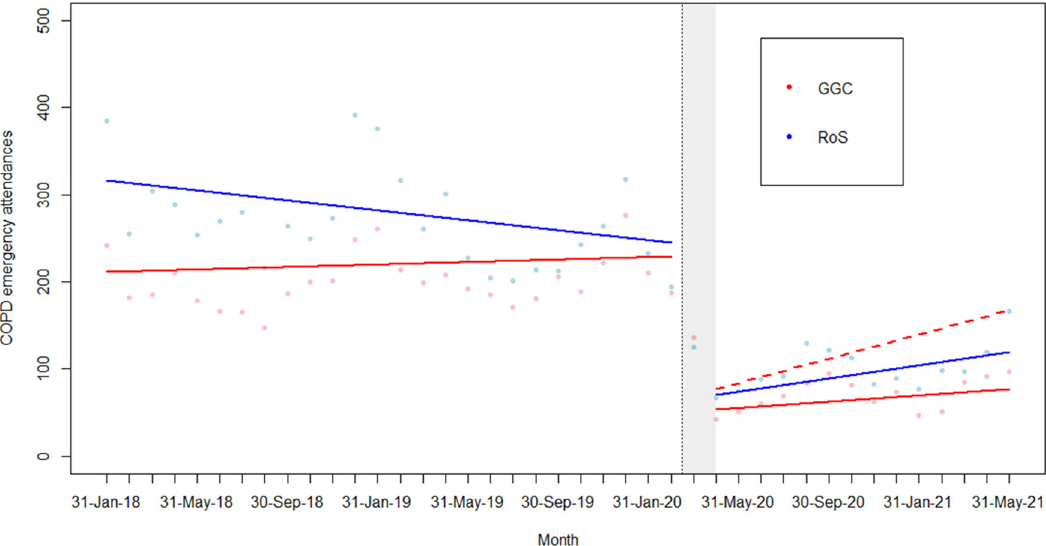
Fig. 3 The effects of the CRRT on COPD emergency admissions. Segmented linear regressions of COPD EAs in Greater Glasgow and Clyde with the Rest of Scotland, excluding Fife, Lothian and Tayside (RoS) as control and adjusting for all other cause emergency attendances (EAs), January 2018 – May 2021; deseasonalized linear trend under model and the predicted trend had the community respiratory project not been implemented.